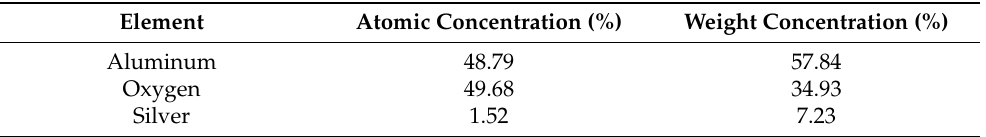
Table 1. Composition of SERS substrate with 13 deposition cycles determined via EDS